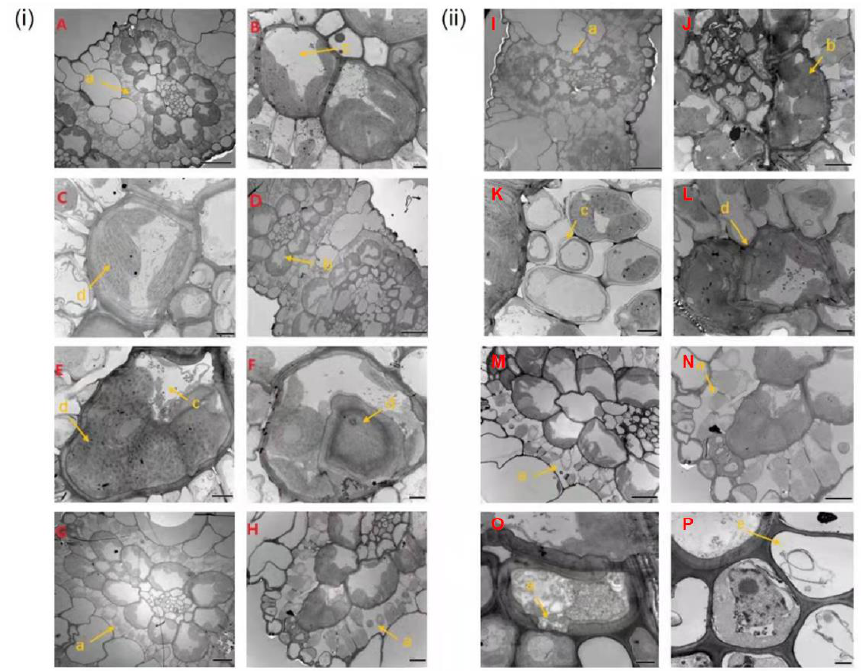
Figure 2. Leaf slices of rust-resistant Z. japonica (RR) ( A – H ) and rust-susceptible Z. japonica (RS) after inoculation with P. zoysiae . ( i ) Inoculated RR leaves; ( ii ) Inoculated RS leaves; ( A , I ) Non-inoculation; ( B , J ) 1 day post inoculation (dpi); ( C , K ) 3 dpi; ( D , L ) 5 dpi; ( E , M ) 8 dpi; ( F , N ) 10 dpi; ( G , O ) 15 dpi; Int. J. Mol. Sci. 2022 , 23 , x FOR PEER REVIEW ( H , P ) 20 dpi. ( a ) mesophyll cell; ( b ) chloroplast; ( c ) plasmolysis; ( d ) cell wall; ( e ) epidermal cell. Before inoculation, chloroplasts of RR in RS were mostly flat and elliptic, and distrib- uted near the plasma membrane of the cells (Figure 3A). At 1 dpi, starch grains in chloro- plast stroma disappeared and reappeared at 3 dpi in RR (Figure 3B,C). At 5 – 15 dpi, com-